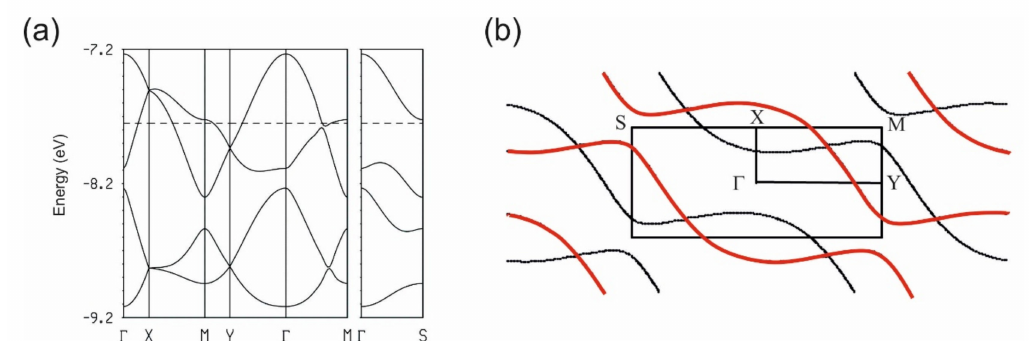
Figure 9. ( a ) Extended Hückel band structure and ( b ) Fermi surface for the donor layers of [( R )- 1 ] 2 ClO 4 . The dashed line refers to the calculated Fermi level and Γ = (0, 0), X = ( a * / 2, 0), Y = (0, b * / 2), M = ( a * / 2, b * / 2) and S = ( a * / 2, − b * /